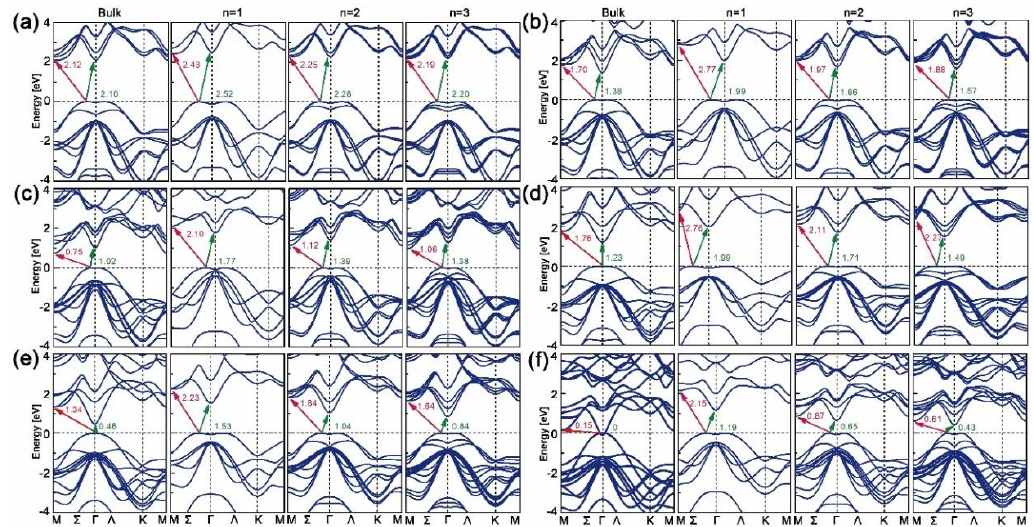
Figure 2. Band structures of bulk, mono-, bi- and trilayered ( a ) GaS, ( b ) GaSe, ( c ) GaTe, ( d ) InS, ( e ) InSe and ( f ) InTe calculated with WC-GGA functional.